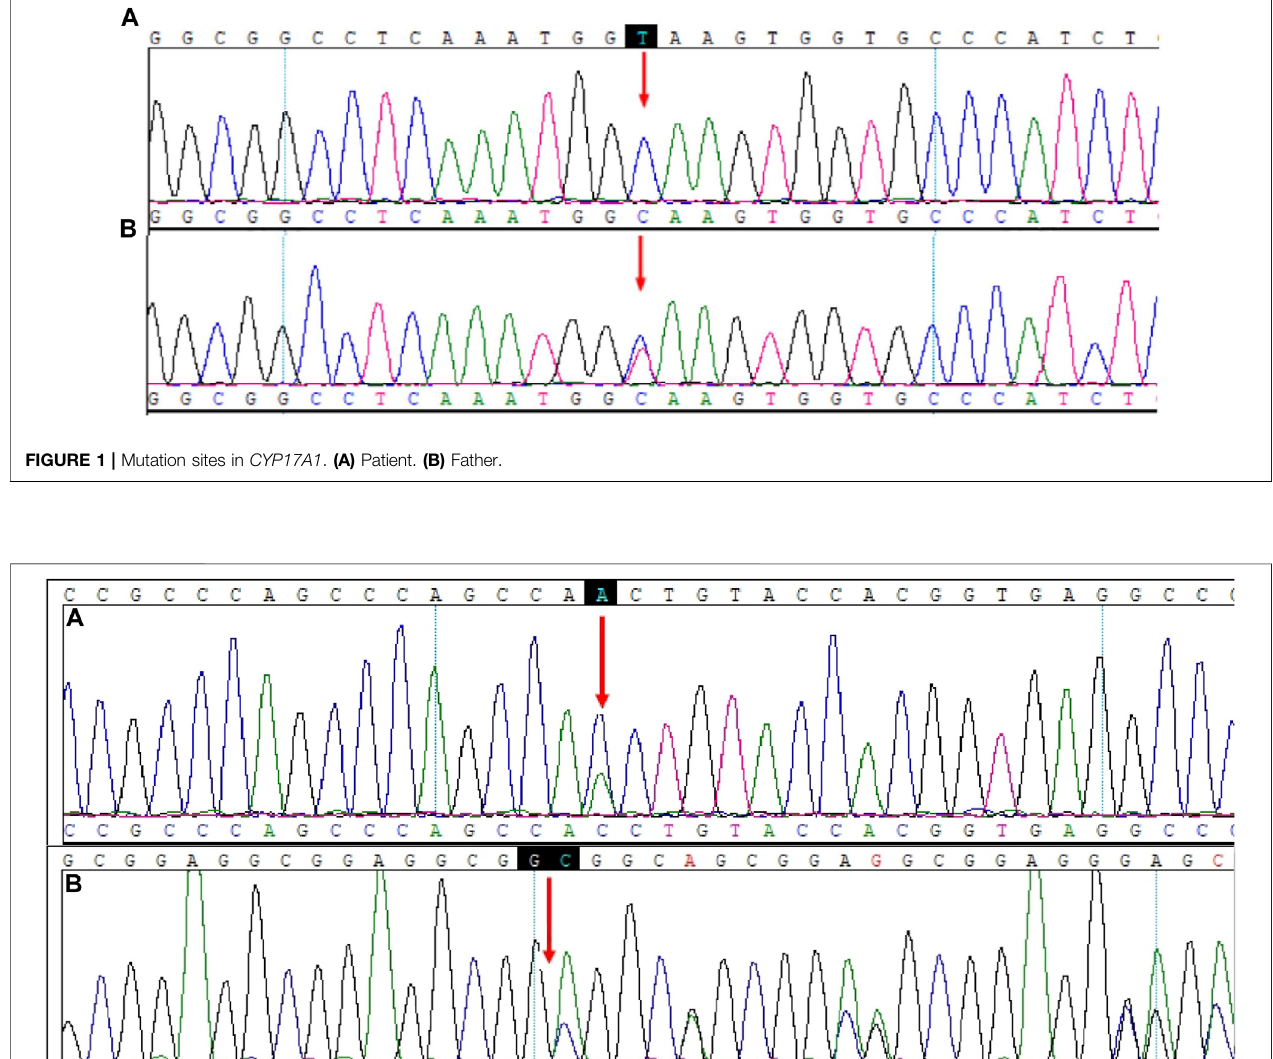
CONDEL meta-prediction aggregator predicted that the c.1069T > C variant was deleterious, with uncertain clinical signi fi cance according to the ClinVar database. The Franklin ACMG Classi fi cation suggested the variant was VUS. The variant